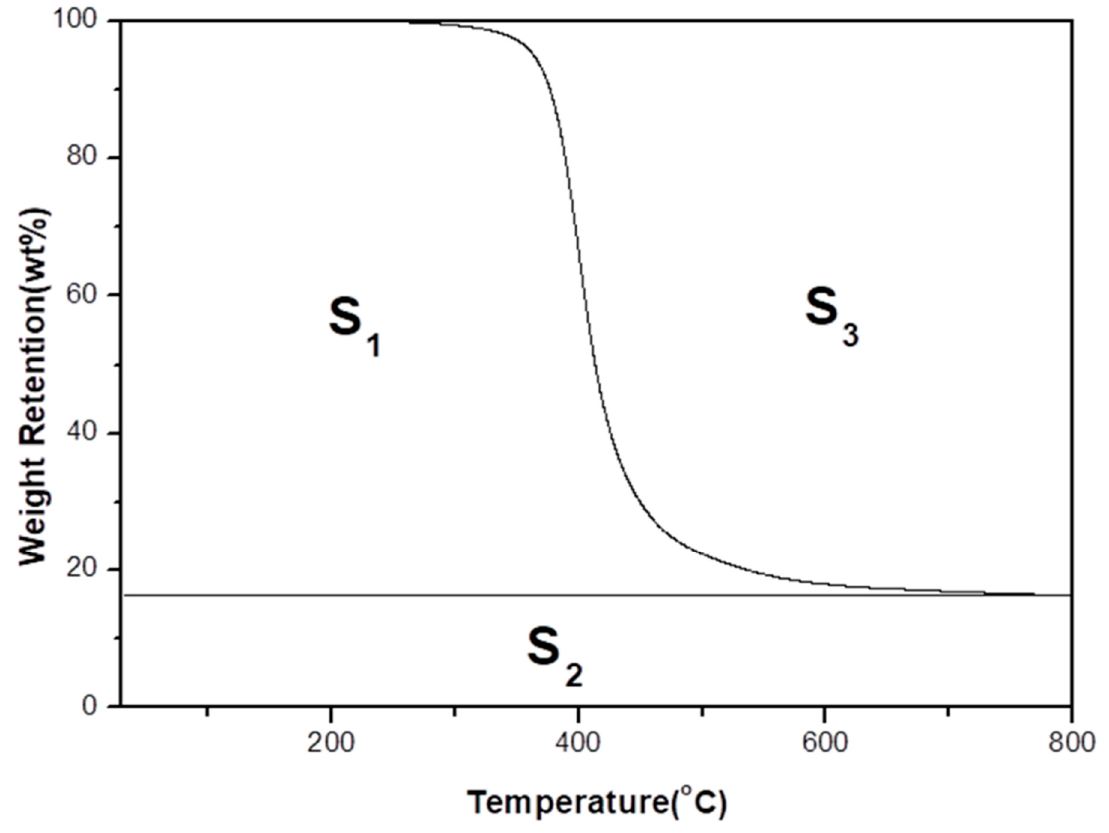
Figure 8. TGA plot.